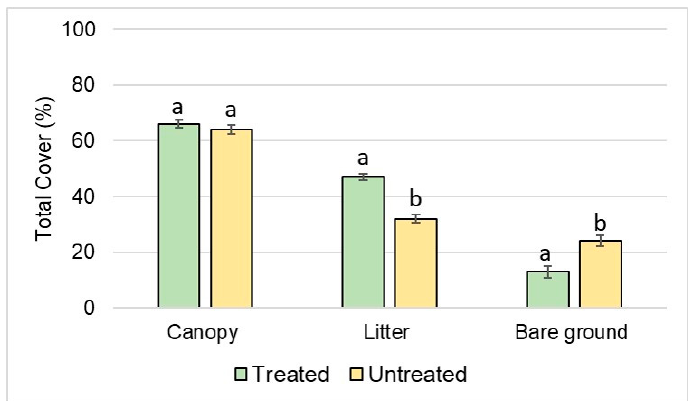
Figure 2. Mean (± SE) values of total canopy cover, litter and bare ground for the treated and untreated watersheds. Means with the same letter are not significantly different (p > 0.05).